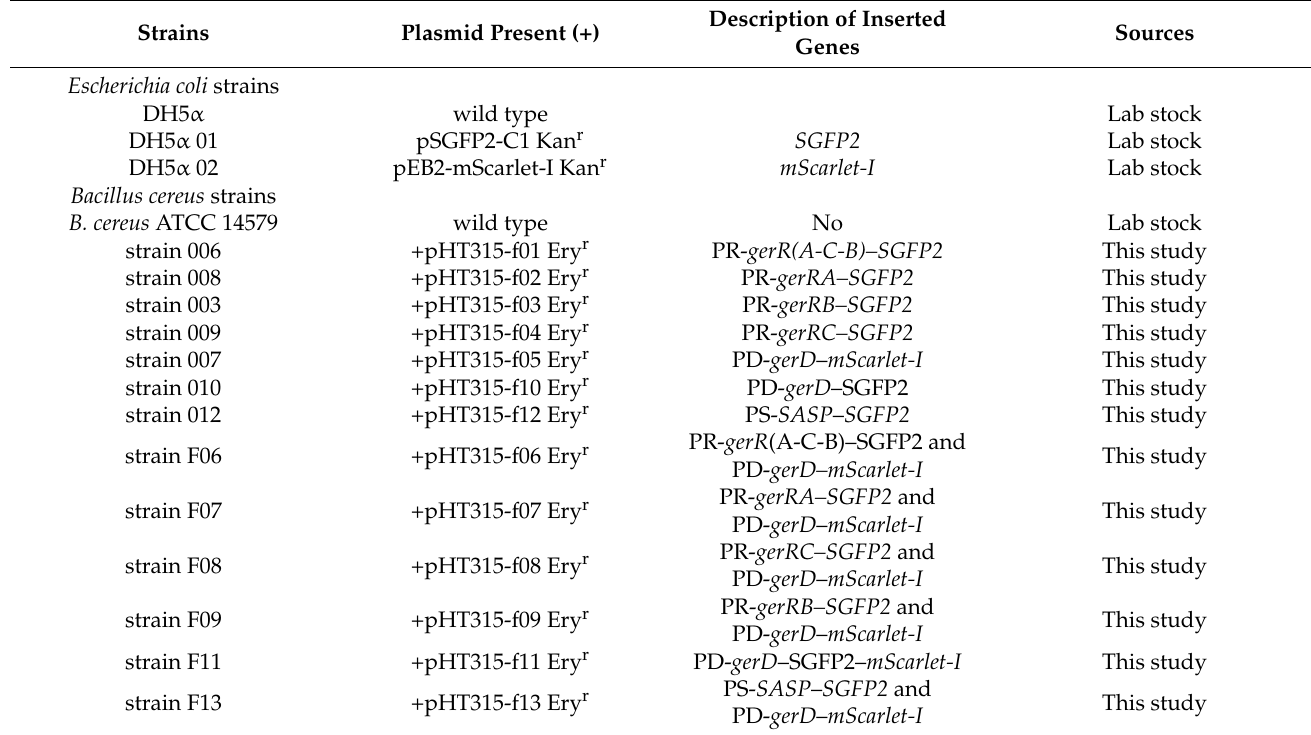
Table 1. Strains and plasmids used in this study.